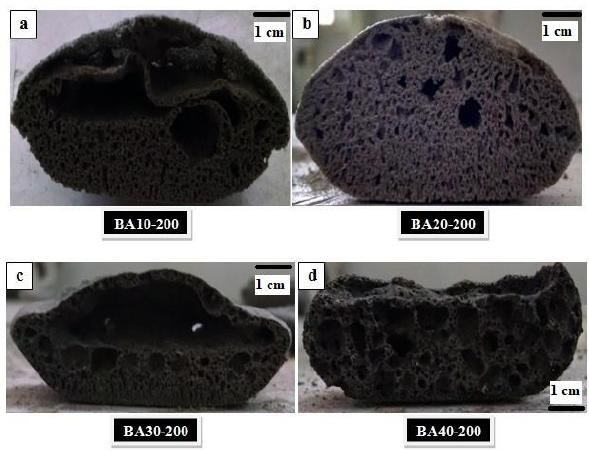
Figure 2. Cross-sections of TGPFs containing, ( a ) 10%; ( b ) 20%; ( c ) 30%; ( d ) 40% BA cured at 200